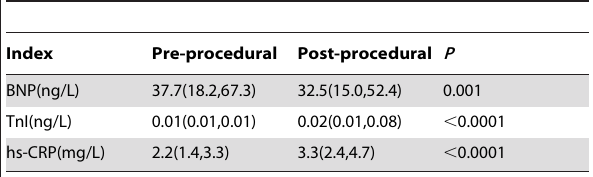
Table 5. Pre-post procedural levels of BNP, TnI and hs-CRP in post-dilation group(M(Q1,Q3)).